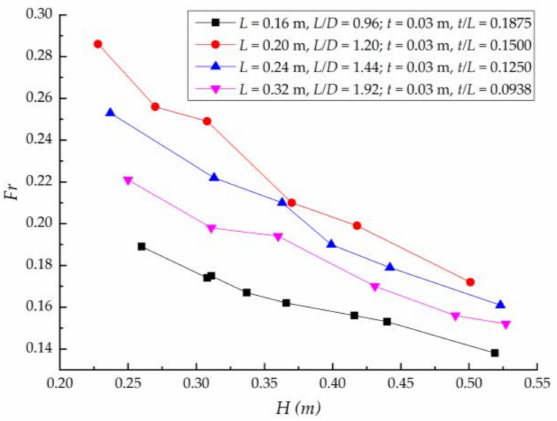
Figure 4. Relationship between critical Fr and H .